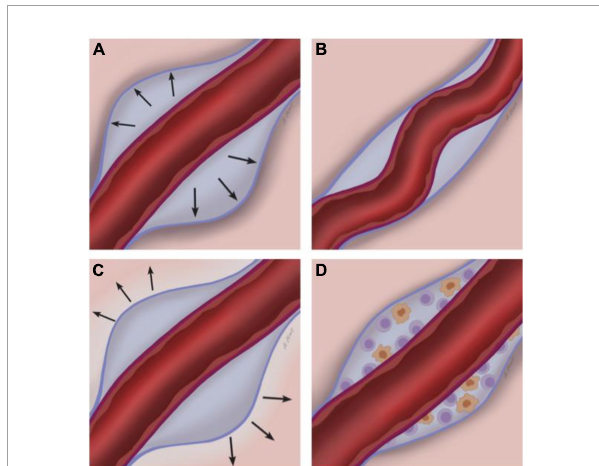
FIGURE3 Potential etiopathogenesis of MRI-visible perivascular spaces (MVPVS). Four overarching and partly overlapping etiologies have been suggested for MVPVS: (A) Impairment of ISF circulation, potentially with abnormal blood-brain-barrier leakage (Fisher, 1979; Wardlaw et al., 2013b); (B) spiral elongation of vessels/tortuous vessels; (C) brain atrophy and/or perivascular myelin loss; and (D) immune cell accumulation in the perivascular space. The perivascular spaces are the compartments between the parenchymal basement membrane of the glia limitans (formed by compacted astrocyte foot processes and an overlying parenchymal basement membrane, blue) and the endothelial basement membrane of the blood vessel (purple) [reviewed in Ineichen et al.